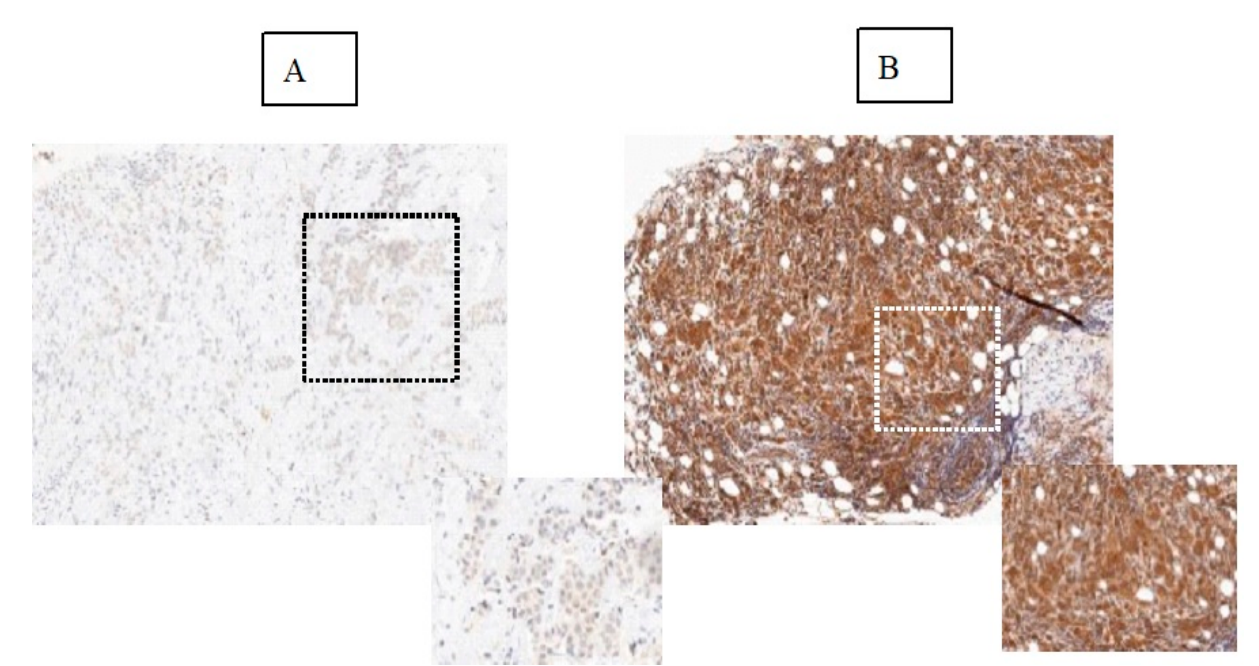
Figure 1. Immunohistochemical detection of Ob-R expression including examples of breast tumors with low ( A ) and high expression of Ob-R ( B ) at ×20 magnification. Highlighted insets show magnification ( × 40) areas. Ob-R expression classification as described by Garofalo et al. 2006 [23].